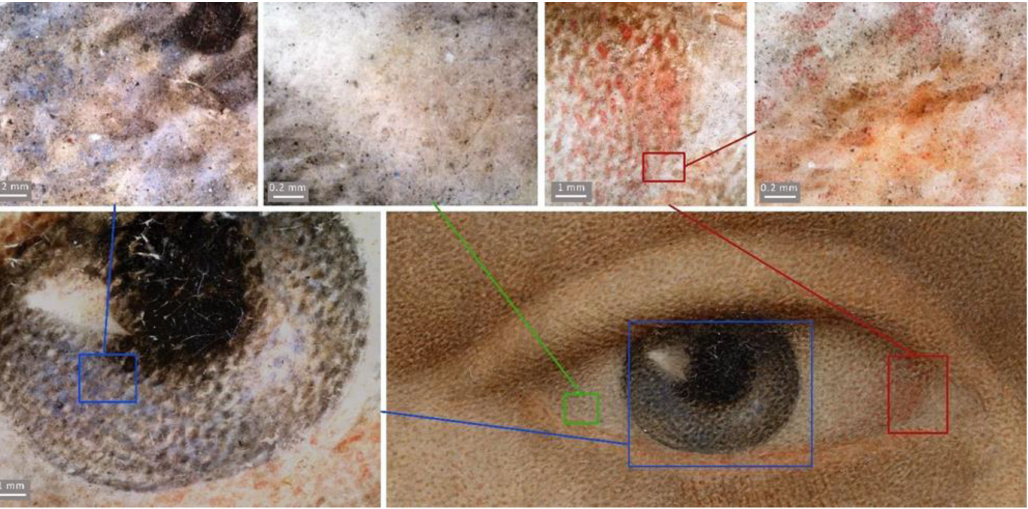
Figure 6. Detail of the right eye of Carlo Emanuele I: microscopic images at different magnifications (50 × and 220 ×